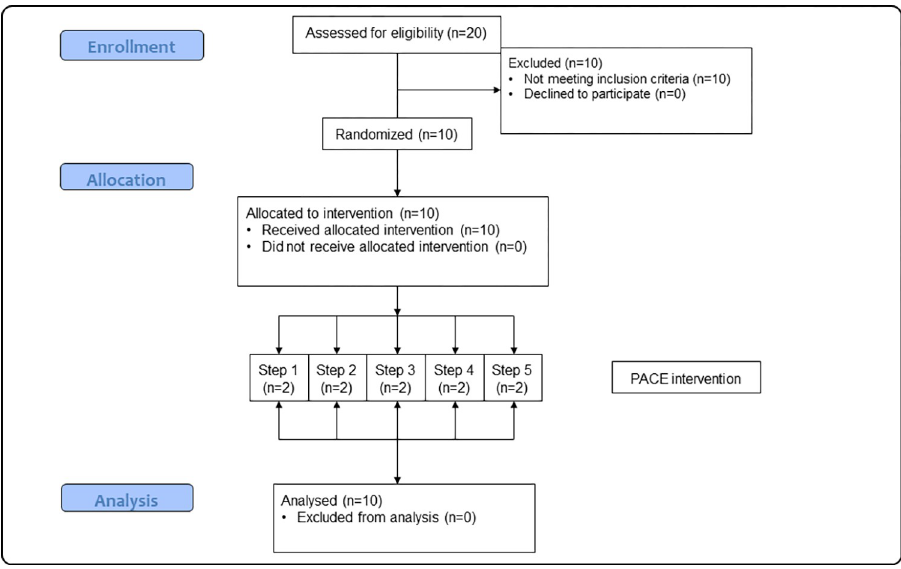
Fig 1. Cafeteria inclusion flowchart. Note . n refers to cafeterias. Each step refers to the different weekly periods in which cafeterias start the interventions.